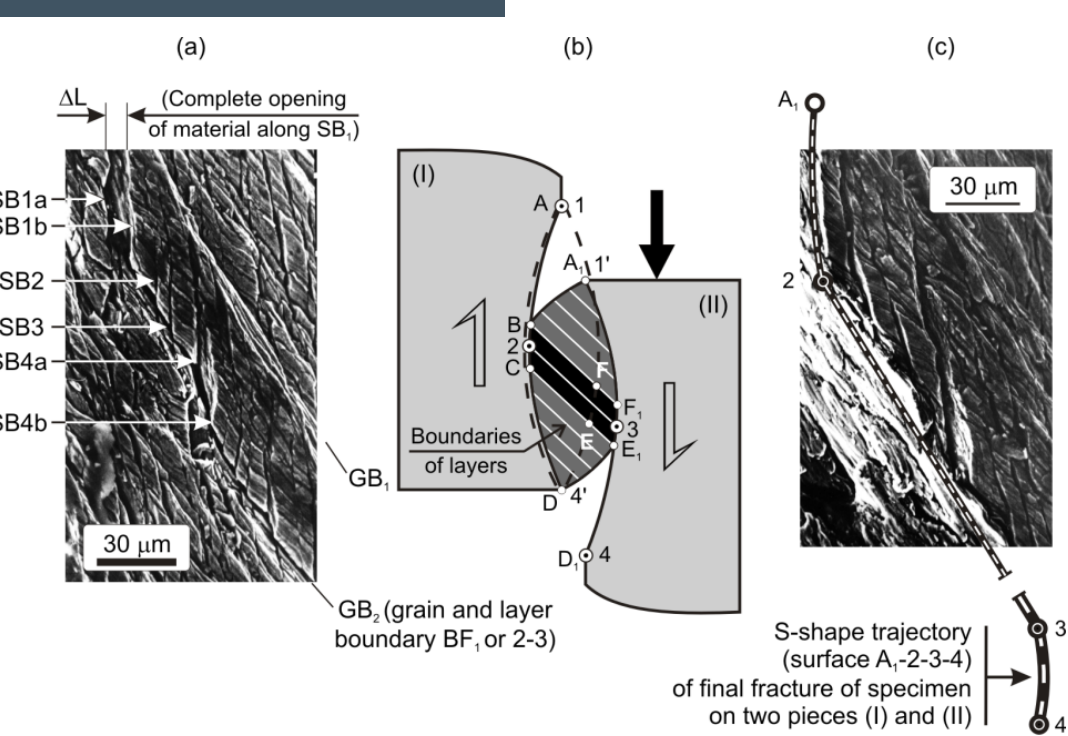
Figure 9. Model of shear fracture mechanism (b) and scanning electron microscopy results which validate it (a, c). According to E.S. Dzidowski. Description in